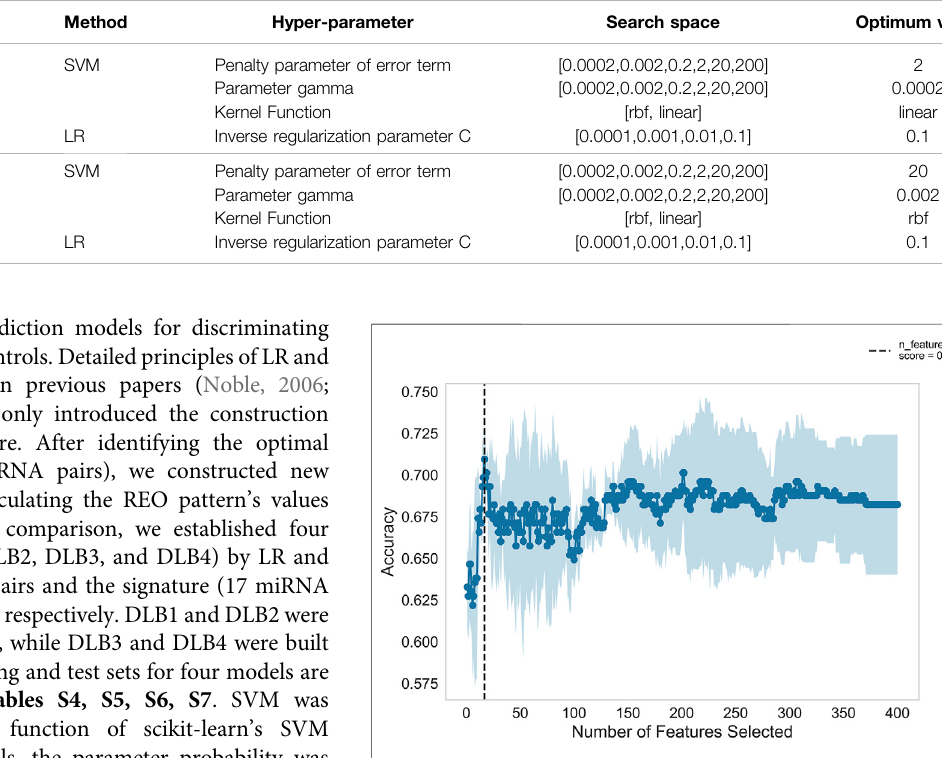
FIGURE 2 | Feature recursive optimization. The dotted line shows the highest accuracy is achieved with 17 features. The horizontal axis is the number of feature selections, and the vertical axis is the prediction accuracy. Shadow areas represent the variability of cross-validation, with a standard deviation higher than and lower than the average accuracy score of curve